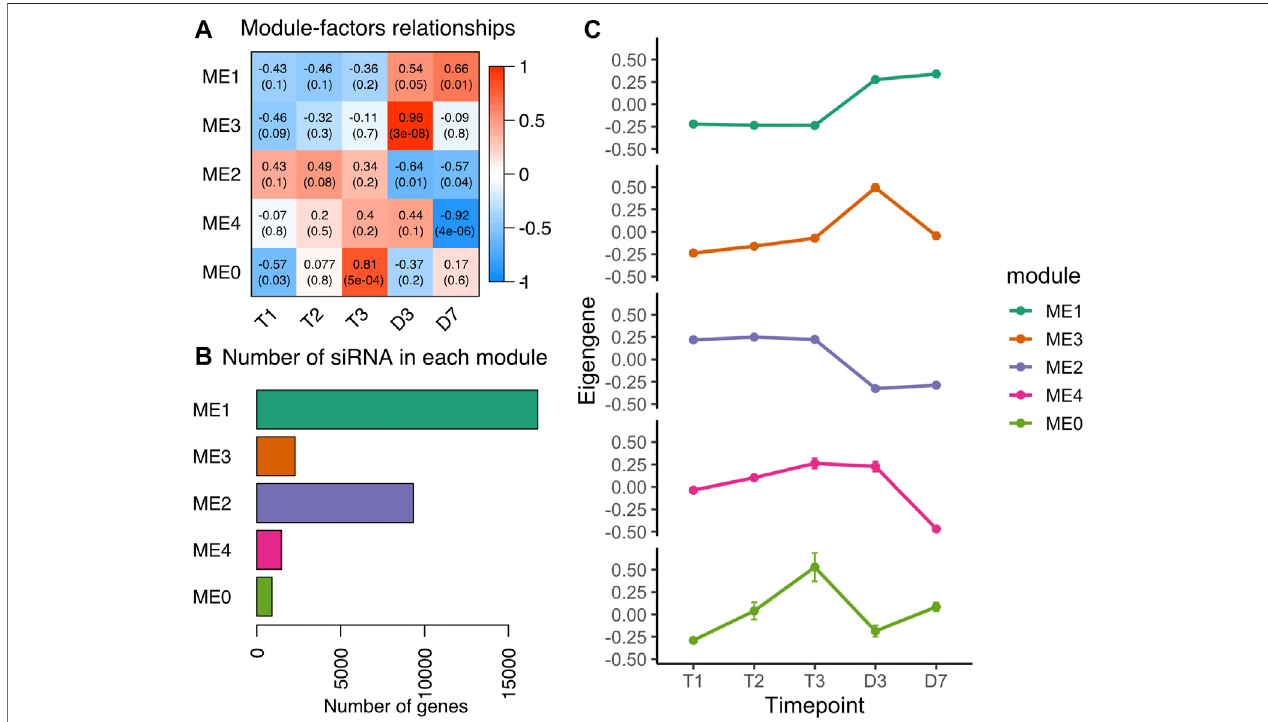
FIGURE 5 | Co-expression analysis of hc-siRNA from dormancy to bud break (A) Module-trait relationships between modules to time points. A higher correlation score indicates ahigher expression levelat thattime point (B) Thenumber ofhc-siRNAs ineach module (C) Theexpression patterns ofeigengene from the fi vemodules (mean ± SE).